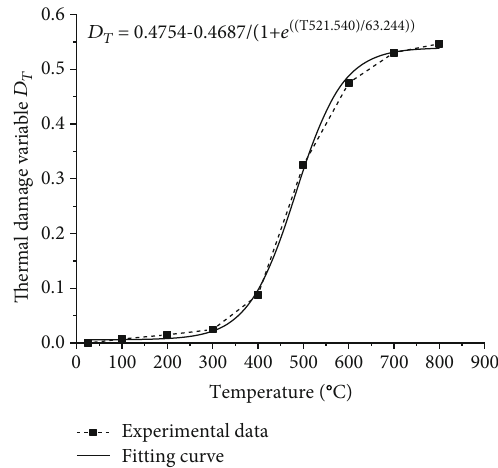
Figure 12: Thermal damage variables of the heat-treated sandstone by di ff erent heated